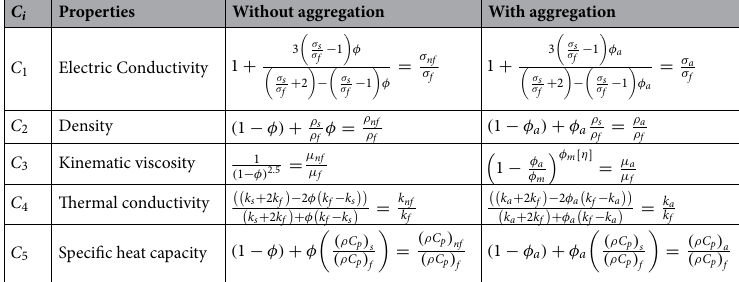
Table 1. Physical properties and their mathematical relationship 39